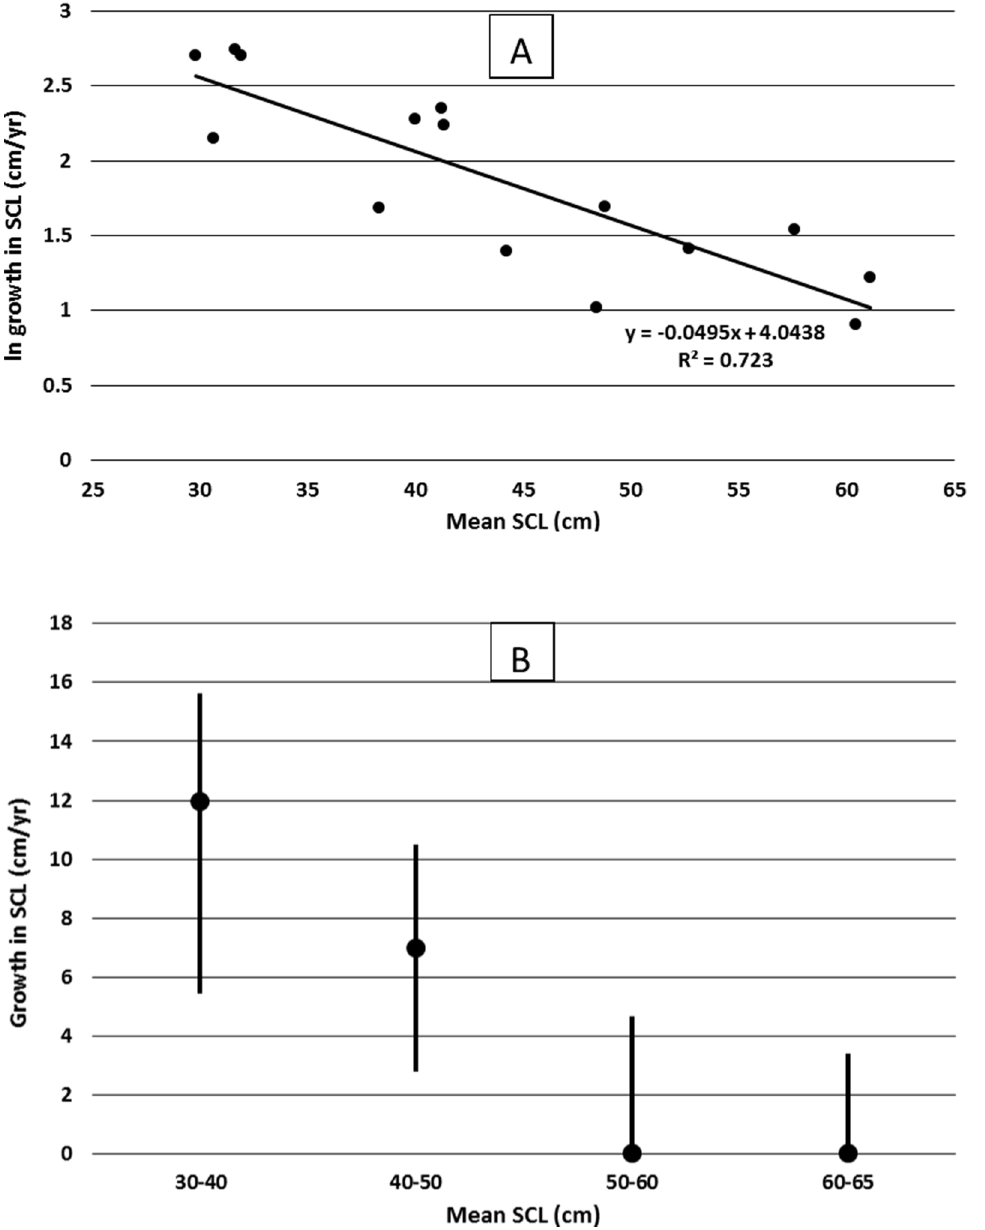
Fig. 3. Growth in standard straight carapace length (SCL) for hawksbill turtles (n 5 15) captured and recaptured within the KWNWR, 2002–2011. Plot A shows a linear fit to log transformed growth rates (R-squared 5 0.70, p , 0.0001), and plot B shows mean growth rates (solid circles) and ranges (vertical lines) for hawksbills within size groupings. All sizes are means of initial and recapture SCL.